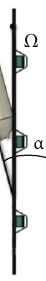
Figure 15: Schematic of impact